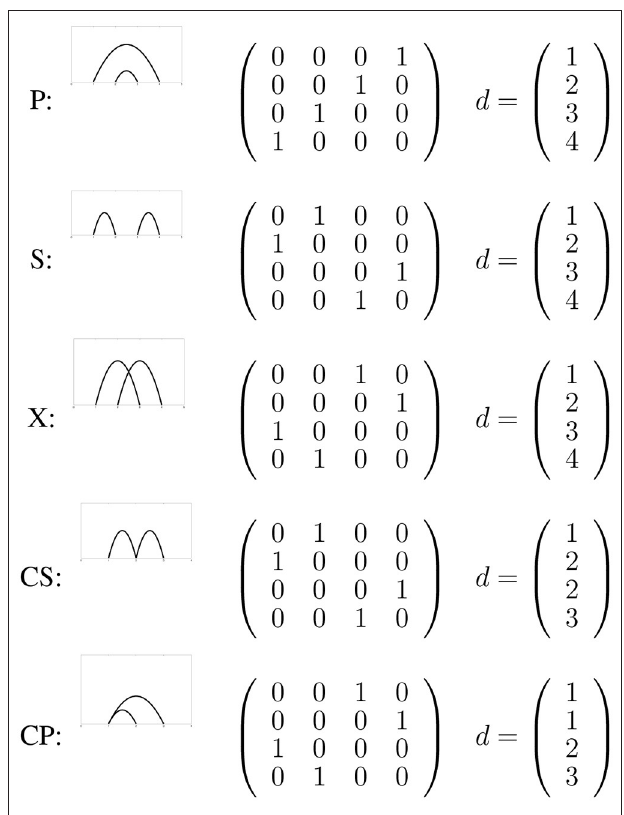
FIGURE 1 | The five types of circuit topology relations representes as a connectivity matrix S and the corresponding graph.